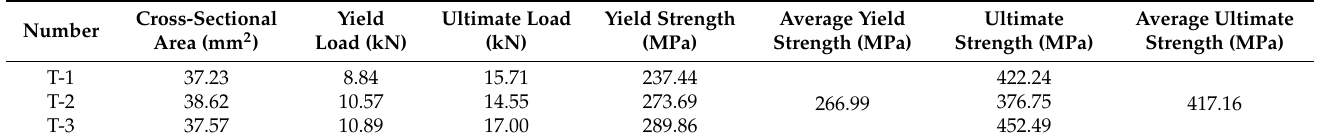
Figure 7. Uniaxial tension tests of dog-bone-shaped specimens: ( a ) loading equipment and ( b ) fail- ure mode. Table 1. Material properties of the sleeve.